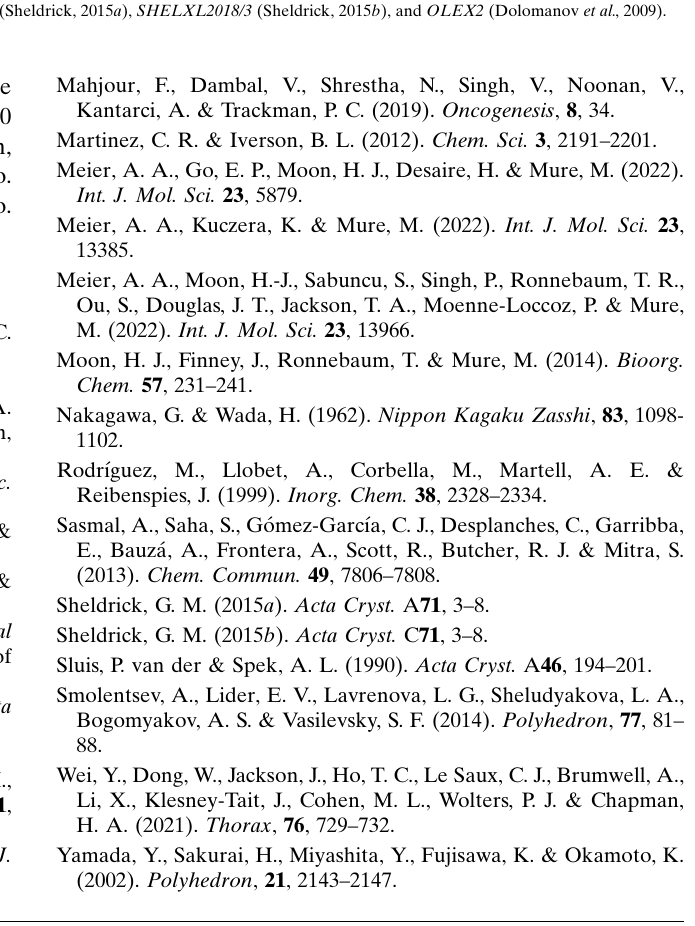
Crystal data Chemical